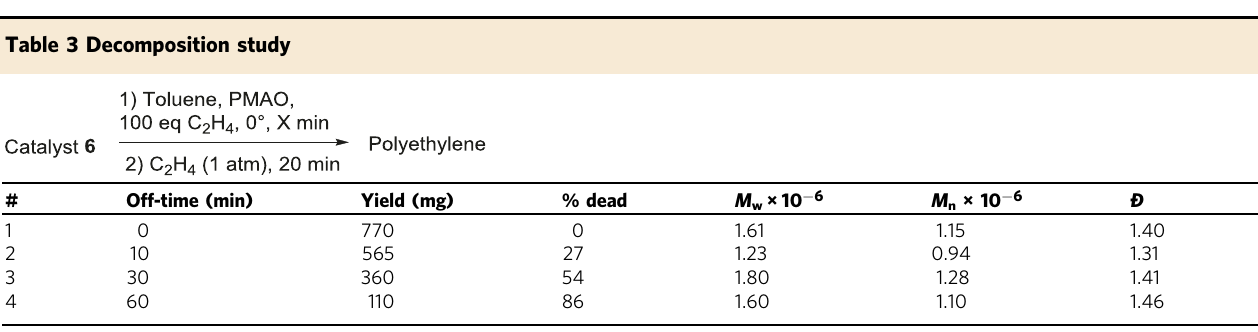
Table 3 Decomposition